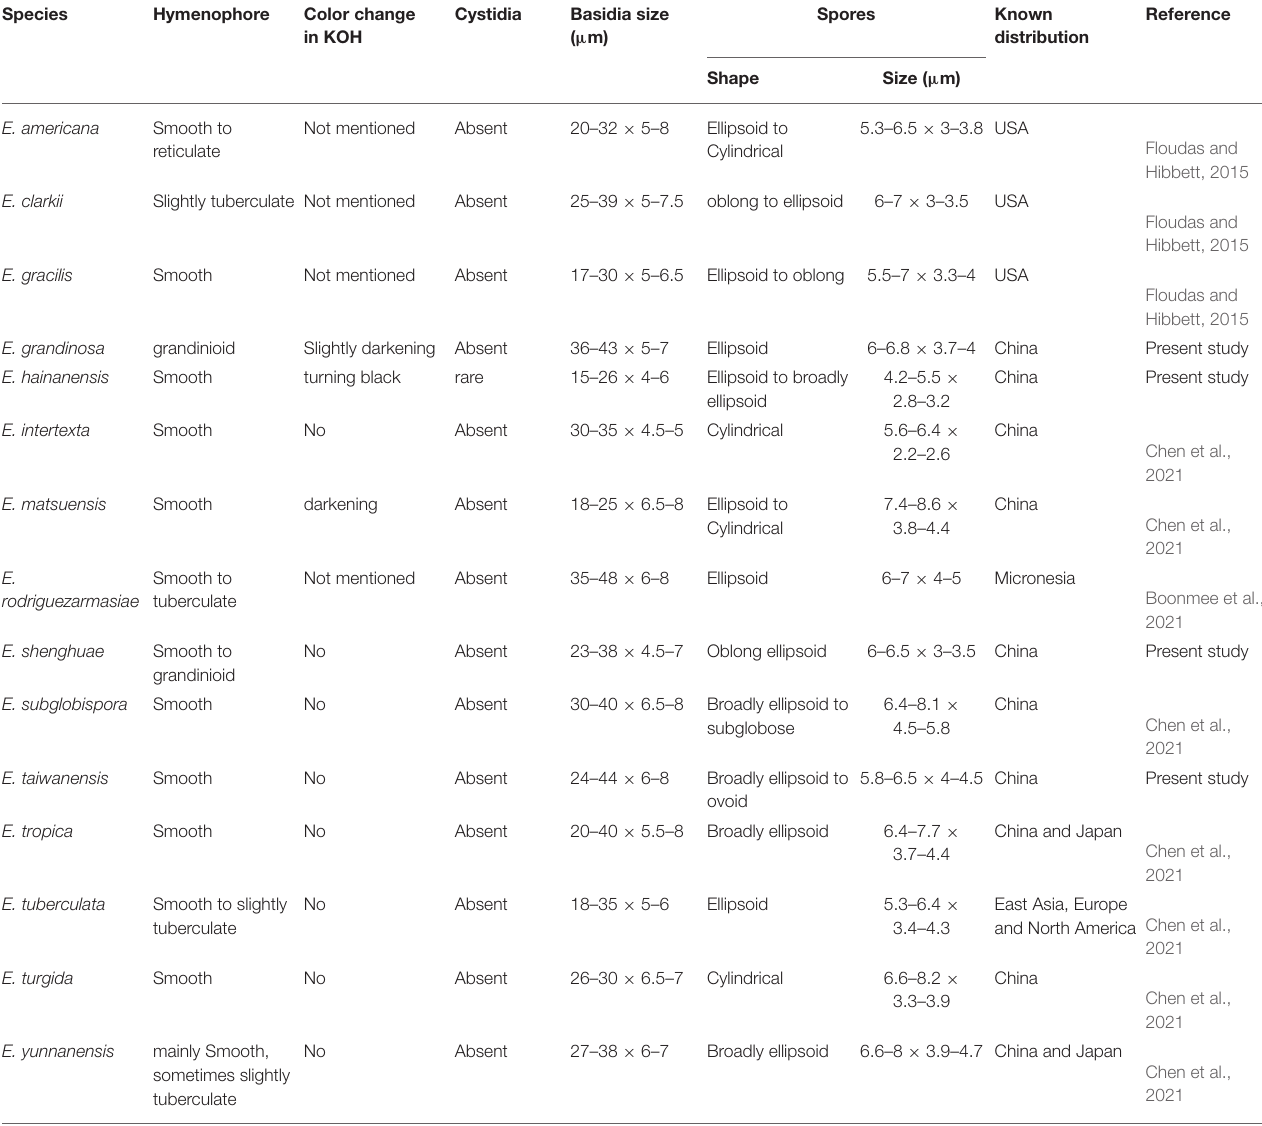
TABLE 2 | Diagnostic characters for species of Efibula